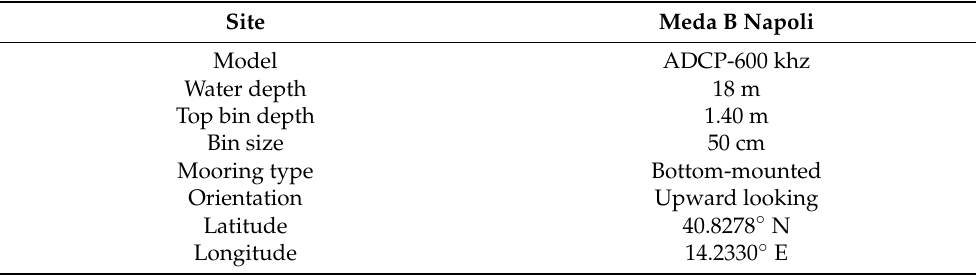
Table 2. ADCP configuration